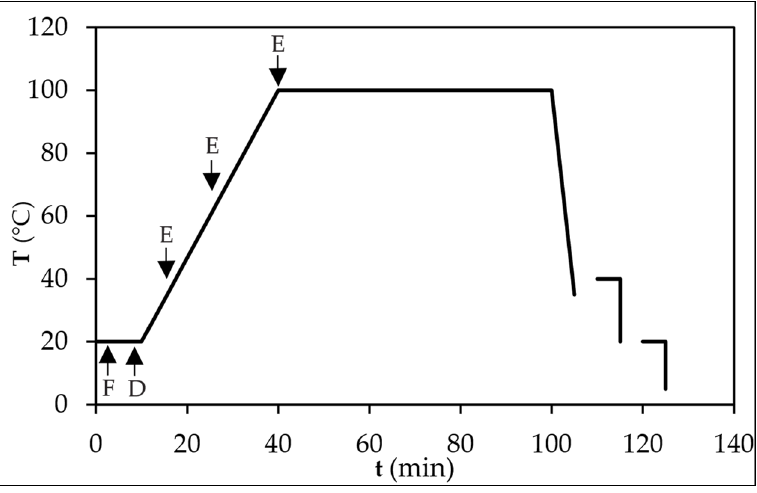
Figure 2. Dyeing diagram (F—fabric, D—dye solution, E—electrolyte solution).